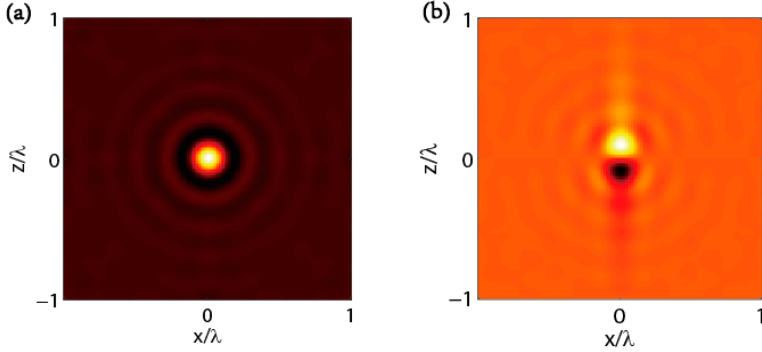
Figure 9. PSF image of TDM in reflection configuration. ( a ) Longitudinal cut of the real part of the PSF at y = 0. ( b ) Longitudinal cut of the imaginary part of the PSF at y = 0.